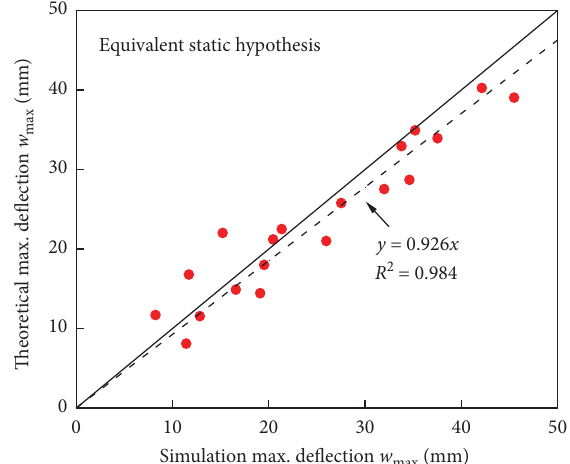
Figure 14: Comparison between the simulation and theoretical results calculated by extended Hamilton’s principle for fully clamped RC beams.